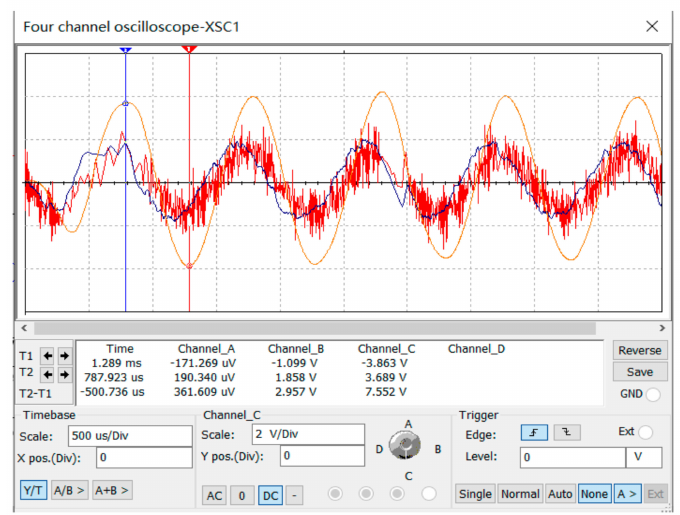
Figure 5. Detection circuit amplification and filtering